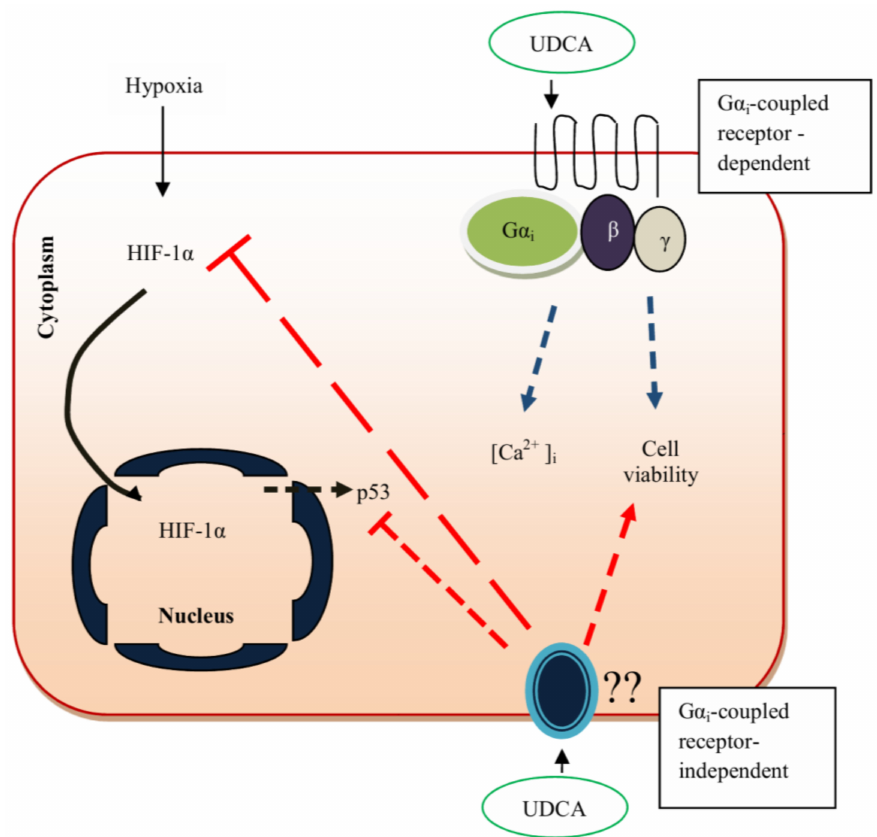
Figure 3. Proposed mechanisms for UDCA cardioprotection in maintaining normal [Ca 2+ ] i and HIF-1 α level. Binding of UDCA to PTX-sensitive receptor partially improves cell survival. However, PTX does not block the effect of UDCA on [Ca 2+ ] i , HIF-1 α translocation, and p53 protein expression against hypoxia. Cell viability is partially inhibited by PTX; dual pathway is suggested to be involved (G α i -coupled receptor-dependent and -independent pathways). Blue arrow, G α i -coupled receptor-dependent pathways; red arrow, G α i -coupled receptor-independent pathways. (UDCA, ursodeoxycholic acid; G α i, G-alpha; β , G-beta; γ , G-gamma; Hif-1 alpha, hypoxia inducible factor 1 alpha; [Ca 2+ ] i , intracellular calcium; p53, cellular tumor antigen